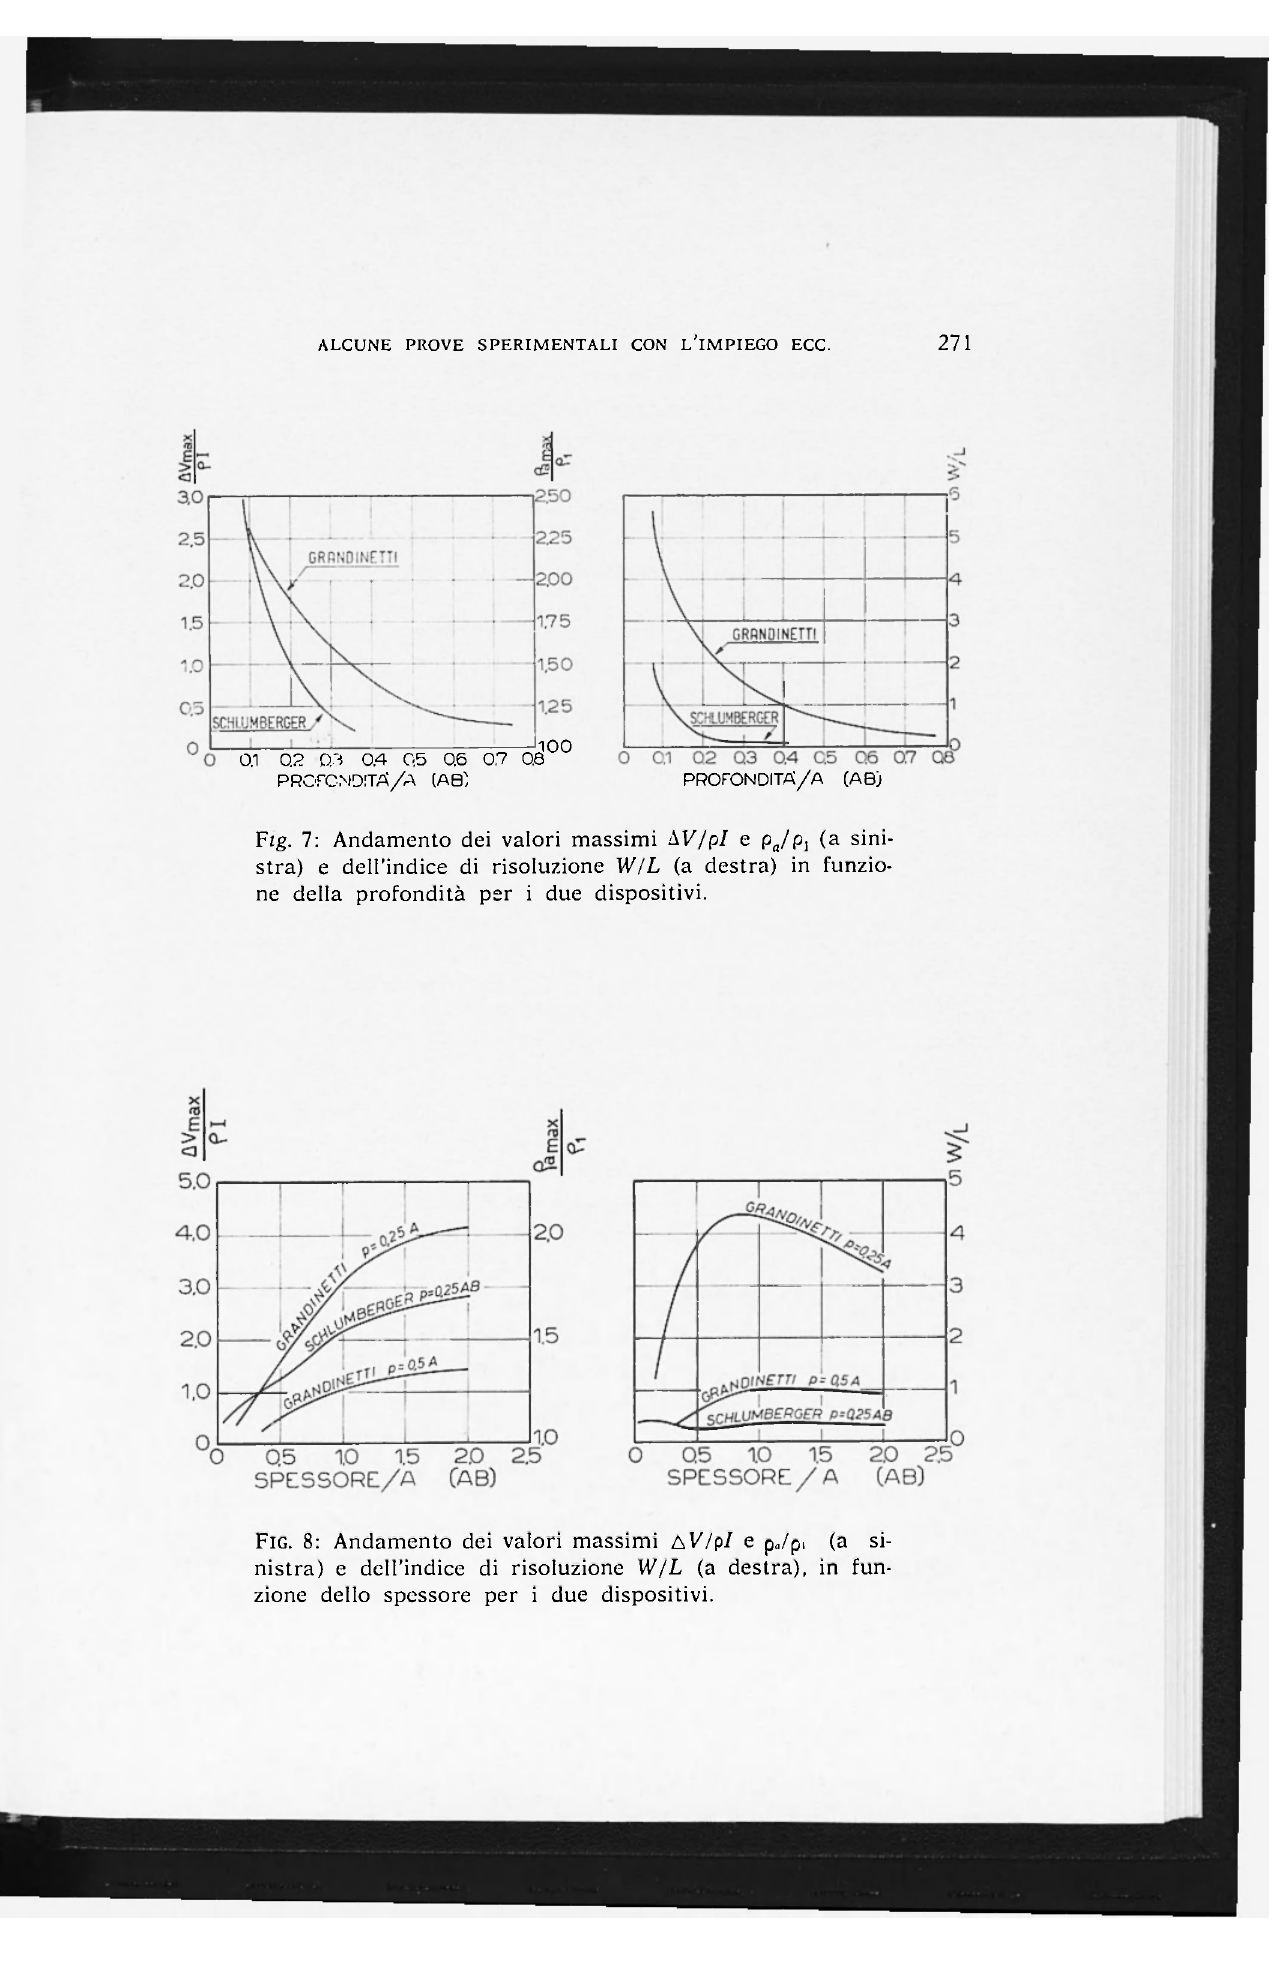
F IG. 8: Andamento dei valori massimi AWp/ e p„/p, (a si- nistra) e dell'indice di risoluzione W/L (a destra), in fun- zione dello spessore per i due